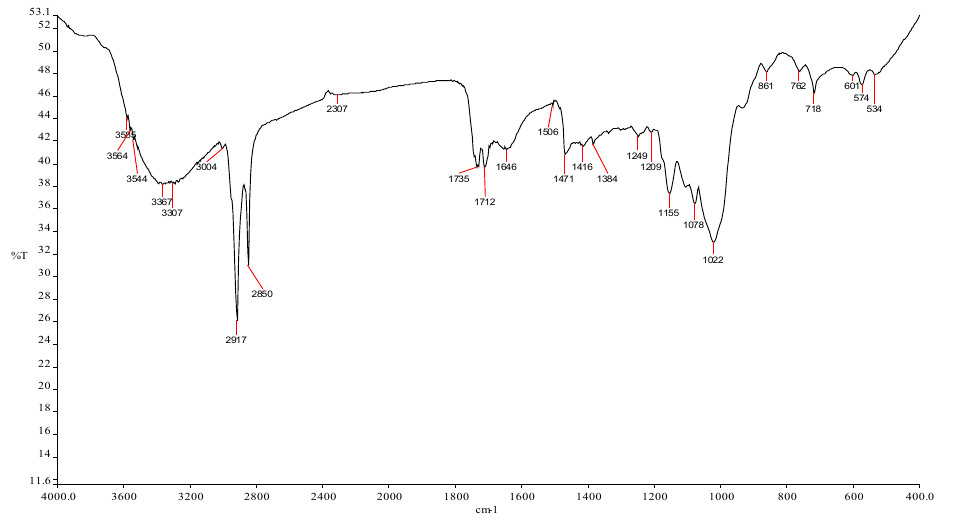
Figure 3. FTIR spectra of Nephelium lappaceum seed. Table 2. Functional groups of Nephelium lappaceum